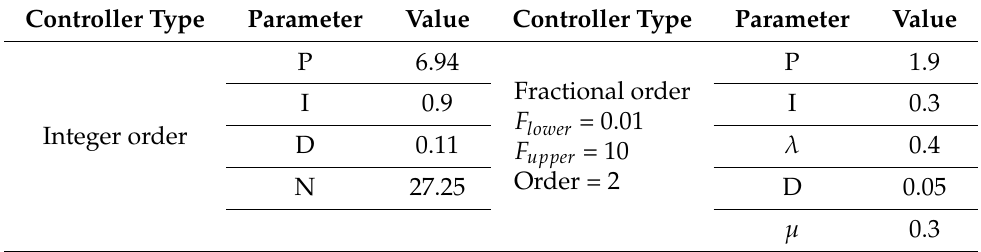
Table 2. PID parameters.